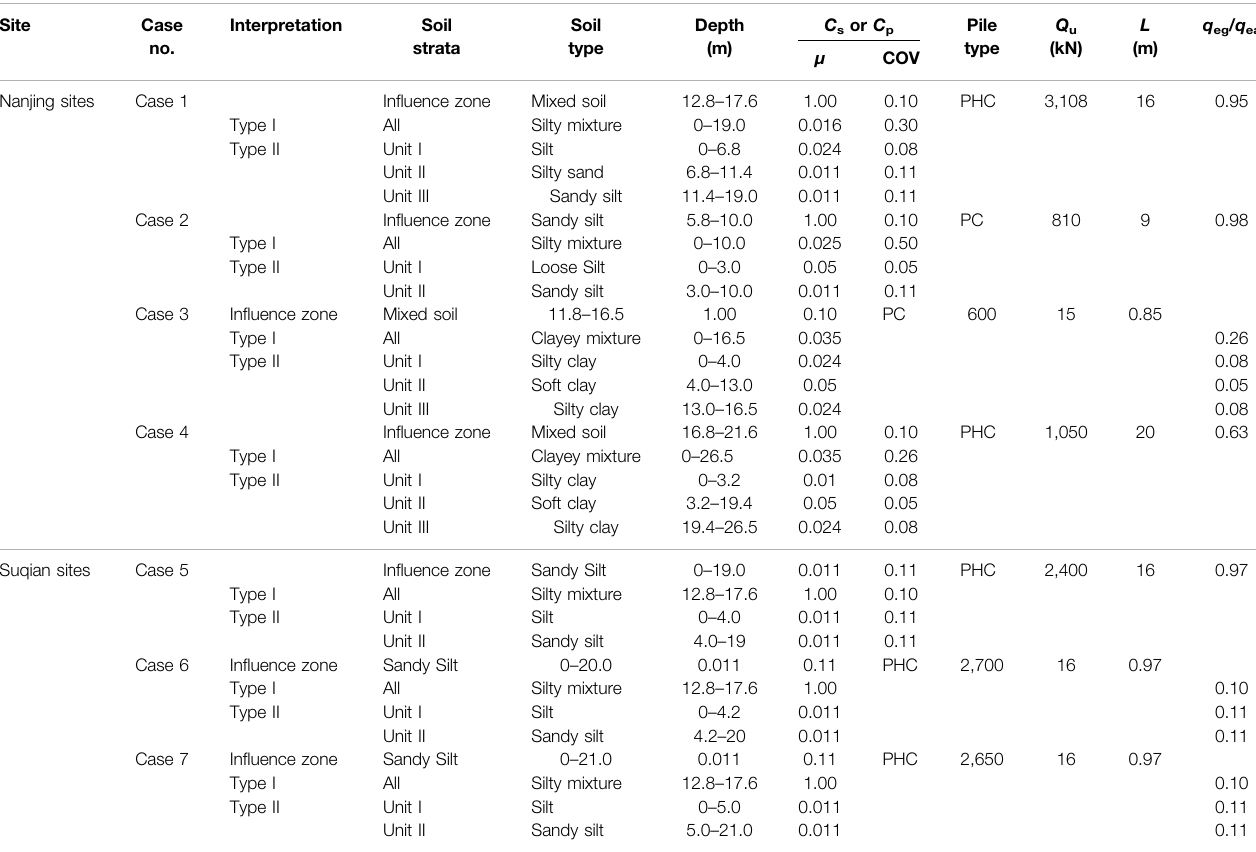
TABLE 4 | Basic information of site strata and piles.